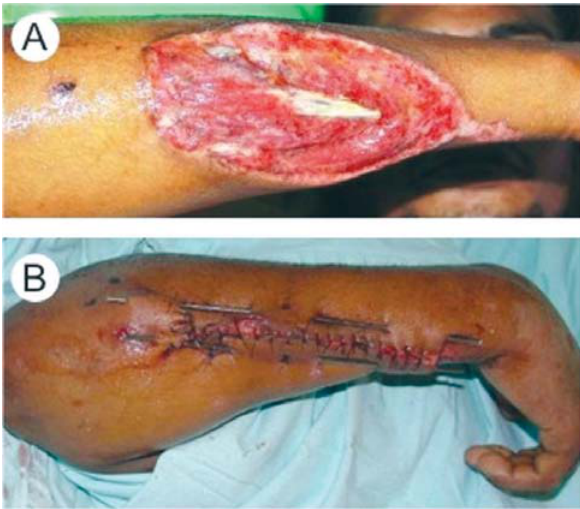
Fig. 1 - A: Ferimento elíptico; B: Retificação das bordas com hastes